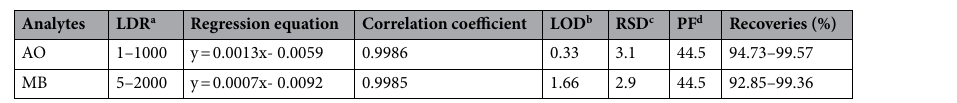
Table 4. Analysis performance of AO and MB extracted with the MgO-NPs. a Linear dynamic range